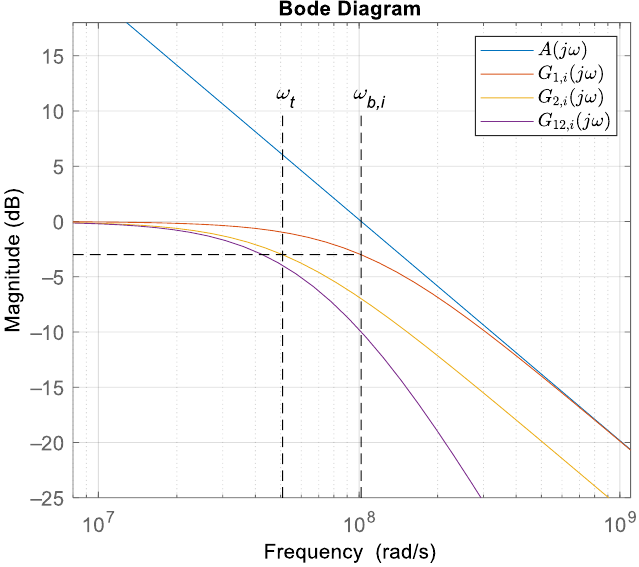
Figure 11. Bode plot of the measurement circuit. From (19) and Figure 11, it follows that the pass-band was defined when the transfer function G i ( j ω) drop for − 3 dB, which was equal to ω b,i and, according to the chosen measurement system frequency f s = 87 kHz (ω s = 5.47 × 10 5 rad/s), the selected OA system satisfied the measurement requirements. Other OAs in the measurement chain had the same cross-over frequency.